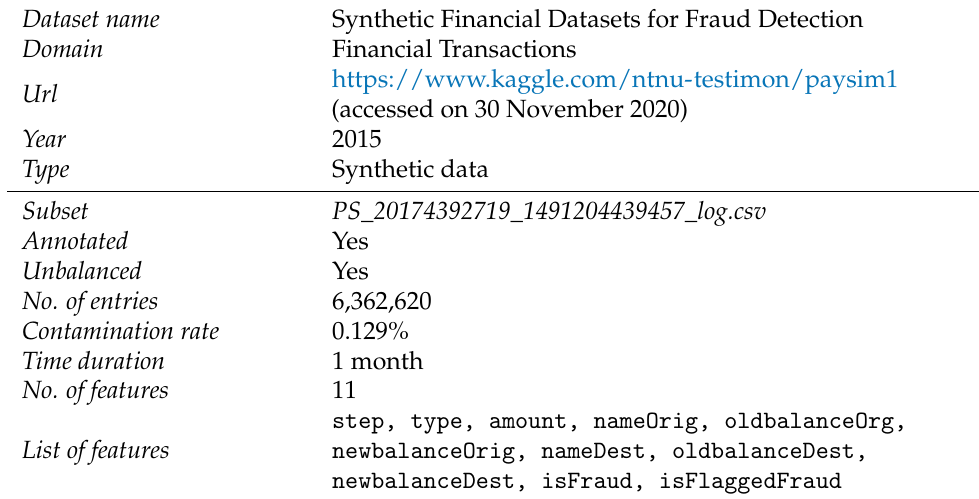
Table 5. Synthetic Financial Datasets for Fraud Detection dataset